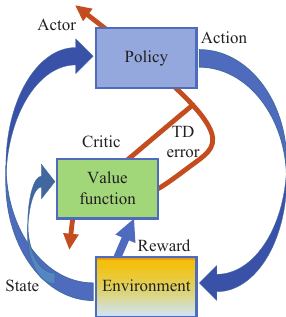
Figure 4. The schematic of the classic actor-critic learning